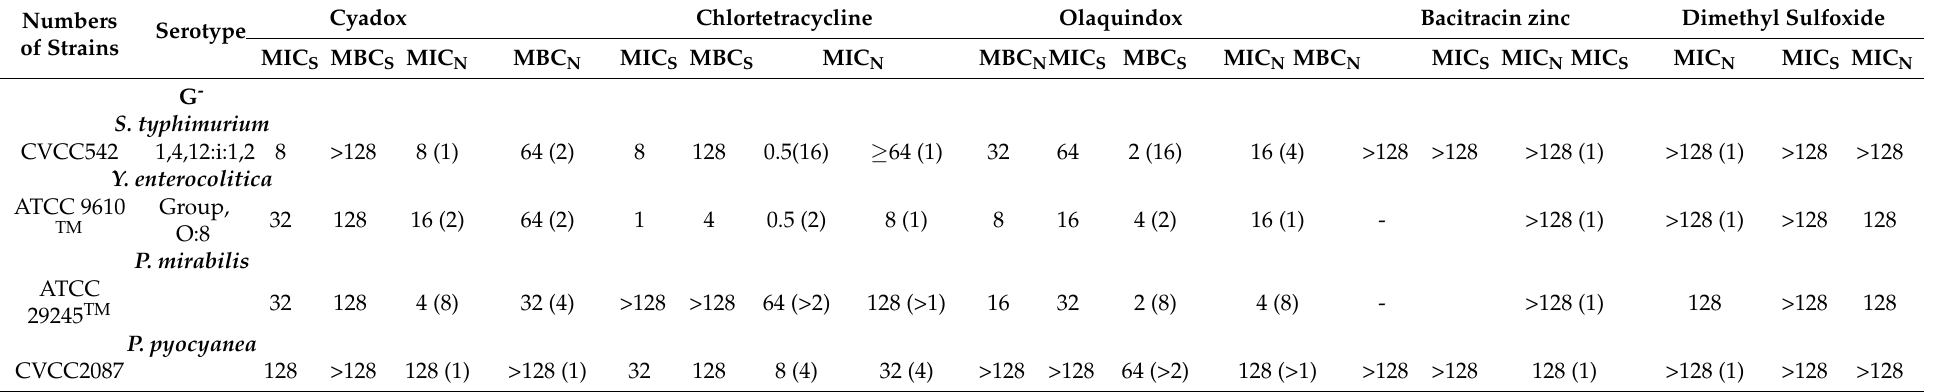
Table 4. Antimicrobial susceptibility of cyadox and controls against pathogens isolated from others (unit: µ